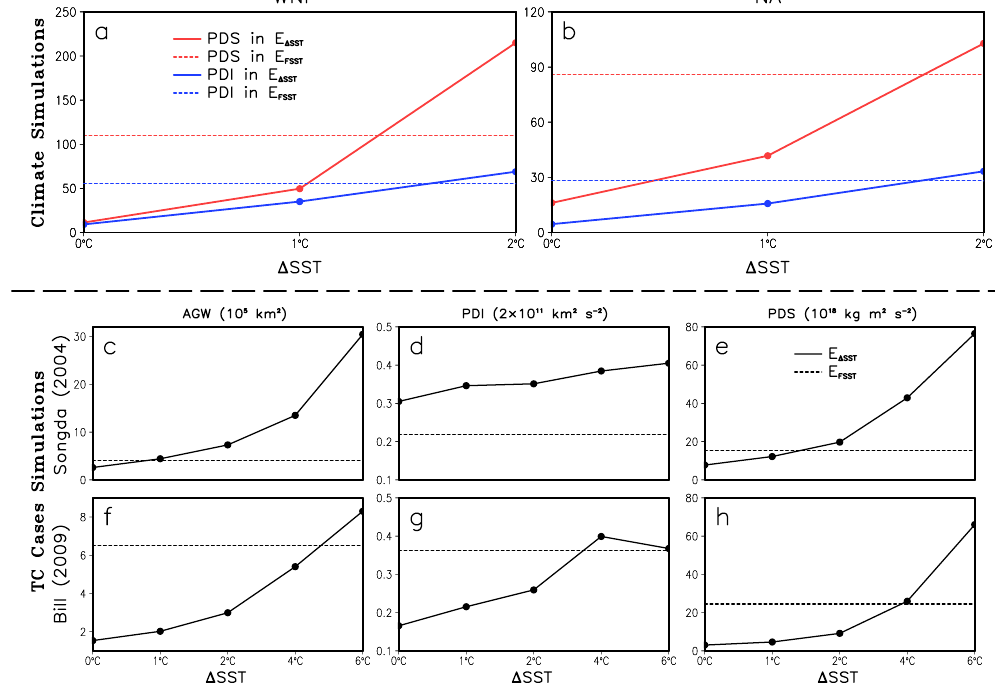
Figure 1. Dependence of the TC destructive potential on SST warming. ( a , b ) Sensitivity of annual PDI (2 × 10 11 m 3 s − 2 ) and PDS (10 18 kg m 2 s − 2 ) during the typhoon season (May-November) to SST warming over the WNP and the NA in the climate simulations. The annual PDI and PDS are averaged over 10 years (2001–2010). ( c – h ) Changes in the time-averaged AGW, PDI, and PDS in response to increased magnitude of SST warming and future SST scenario simulated by the sensitivity experiments for the TC cases of Songda (2004) in the WNP and Bill (2009) in the NA. (E Δ SST includes the CTRL, E all + 1 , and E all + 2 ).